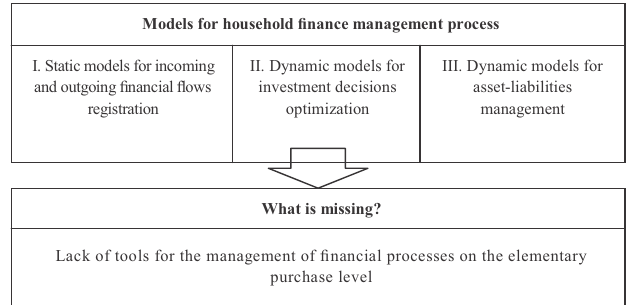
Fig. 1. Summary on methods and tools used for household finance